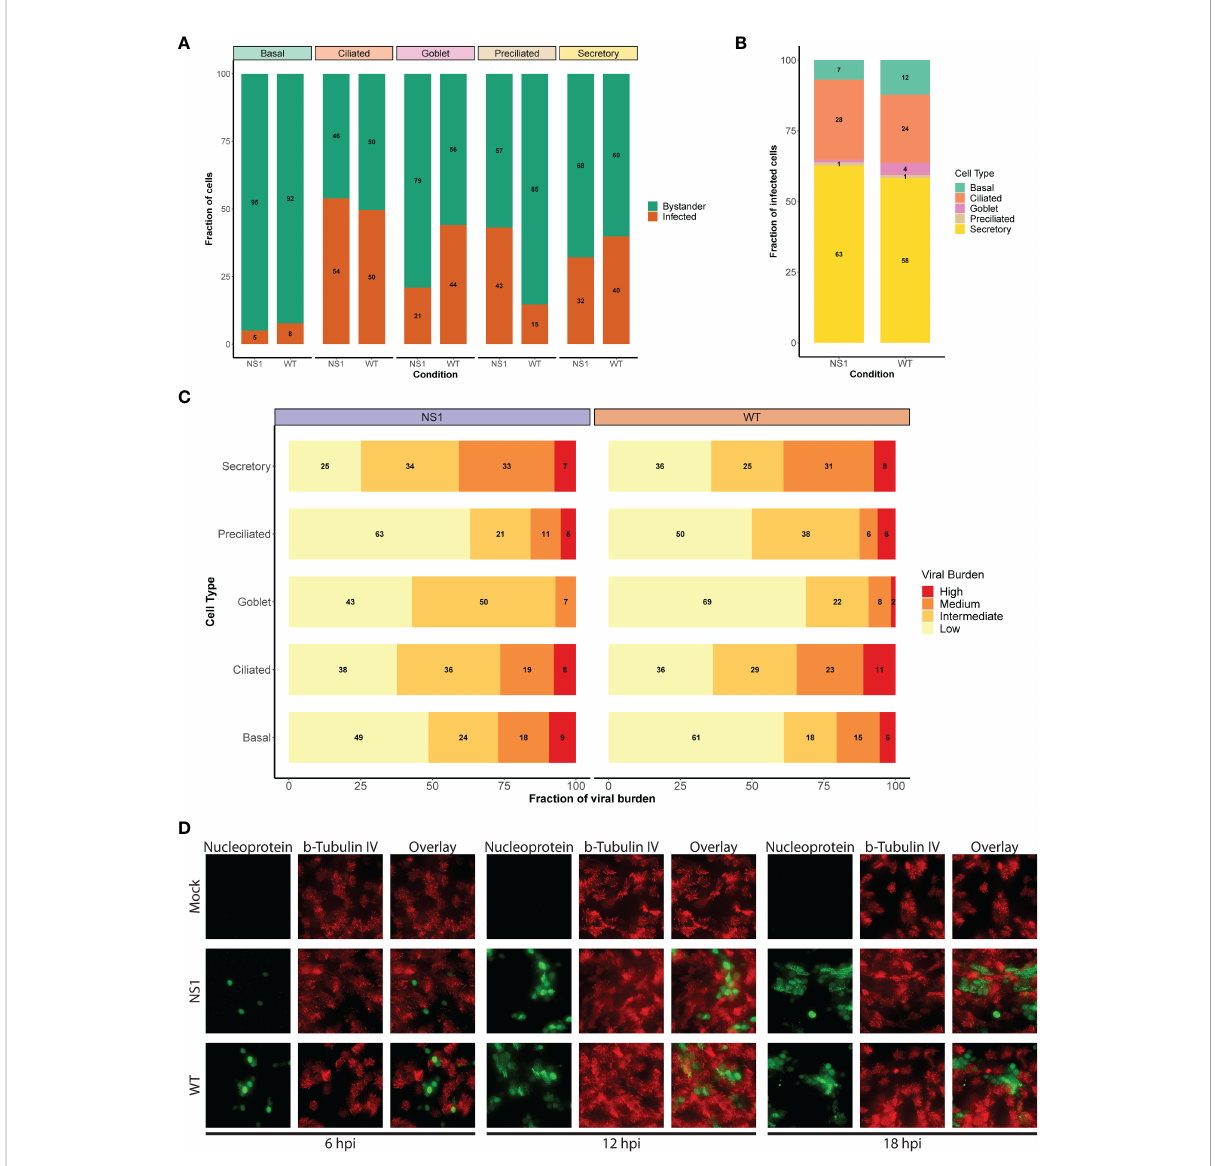
FIGURE 4 Shift in viral host cell tropism at later stages of pandemic IAV infection. (A) Stacked bar graph displaying the percentage of infected (orange) and bystander (green) cells per cell type for WT and NS1 R38A virus-infected hAEC cultures at 18 hpi. (B) Bar graph showing the percentage of infected cells broken down by cell type for WT and NS1 R38A conditions. (C) Graph showing the relative viral burden (x-axis; low, intermediate, medium, or high) among infected cells in each cell type (y-axis) for WT and NS1 R38A conditions. (D) Immuno fl uorescence staining showing viral host cell tropism at 6, 12, and 18 hpi for mock, WT, and NS1 R38A hAEC cultures. For each time point, the viral antigen is shown in green (nucleoprotein, left panel), the ciliated cells are shown in red (ß-tubulin IV; middle panel) and the overlay is shown in the right